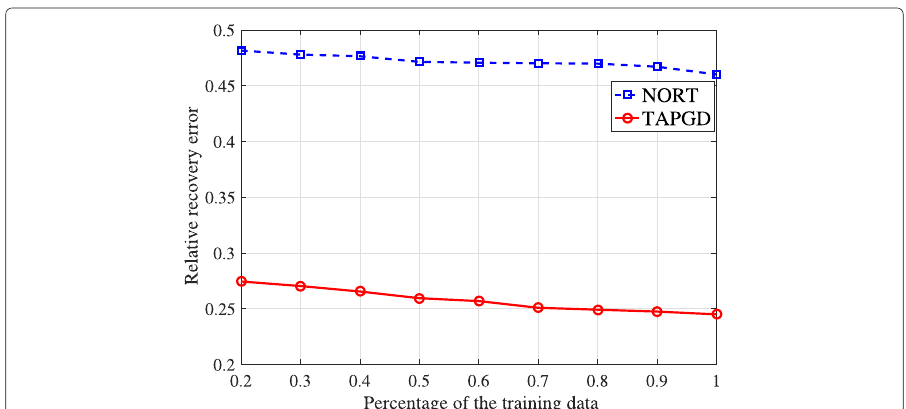
Fig. 10 Comparison of TAPGD to the tensor recovery method NORT [30]: relative recovery error when the observation rate of the observed data changes